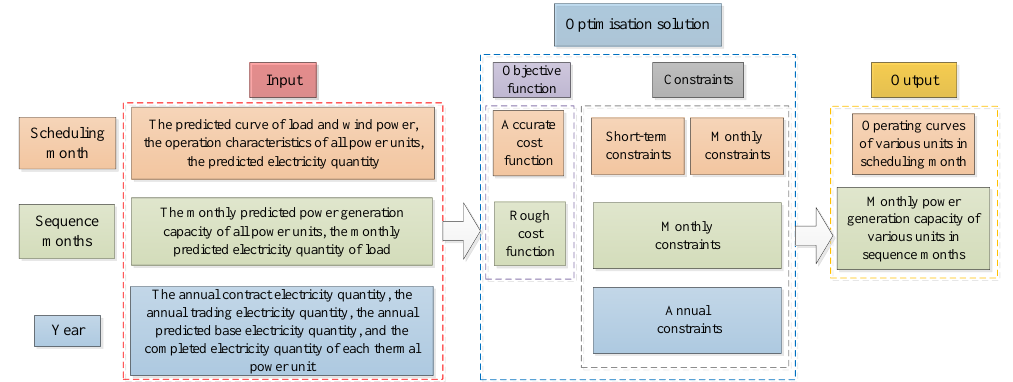
Figure 3. Simulation process of the monthly energy-trade scheduling. Table 1. Electrical energy data of thermal power units.